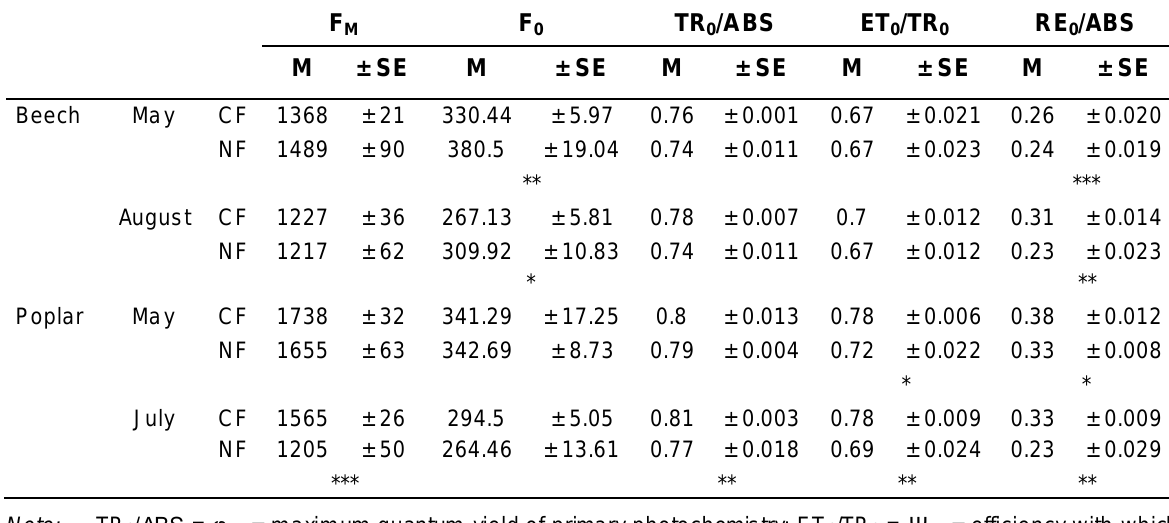
JIP-Test Parameters Calculated from the Original Transients (Mean and Standard Error, n = 4) F